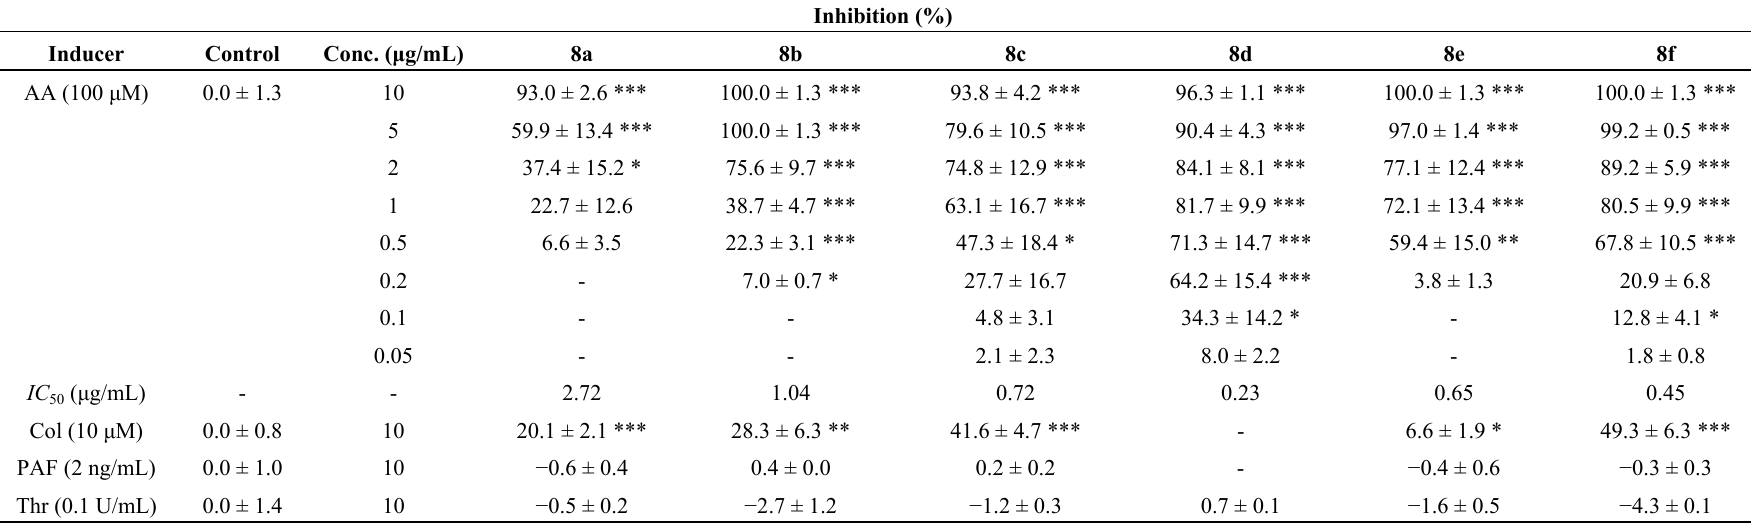
Table 10. Antiplatelet activity of [ n ]-gingerols 8a – f .